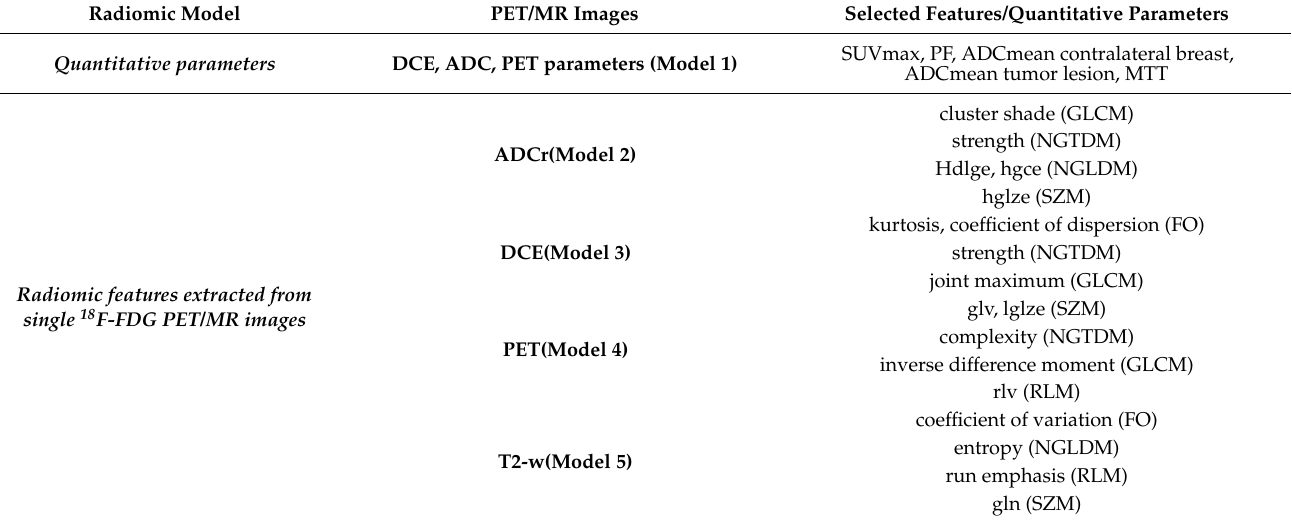
Table 1. Details of the developed radiomics model, including finally selected quantitative parameters and/or radiomic